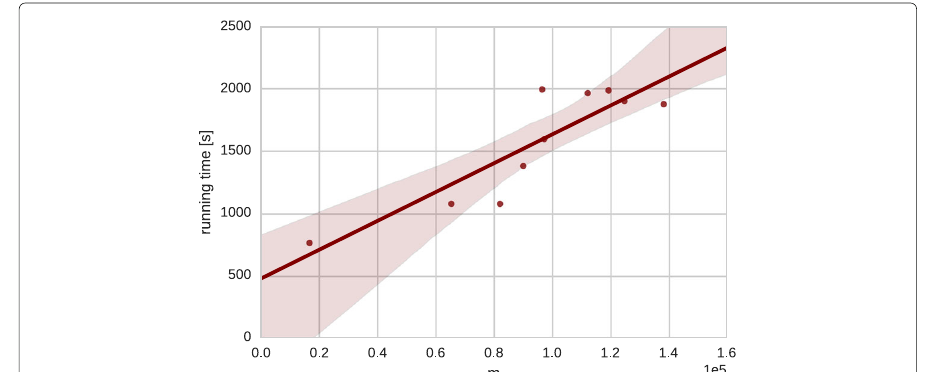
Fig. 2 Running time of 50 iterations of the kronfit algorithm in relation to the number of edges m of the input network